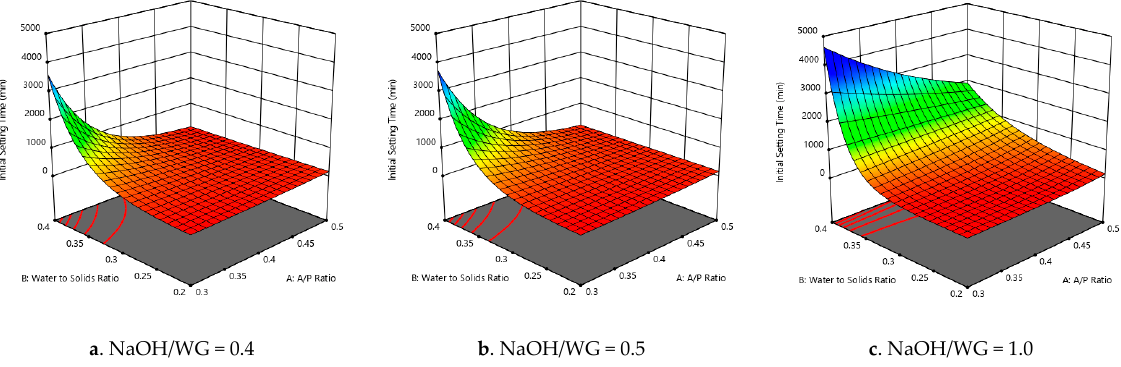
Figure 3. ( a – c ) Initial setting time vs. water-to-solids ratio and A/P ratio for each NaOH/WG ratio value.